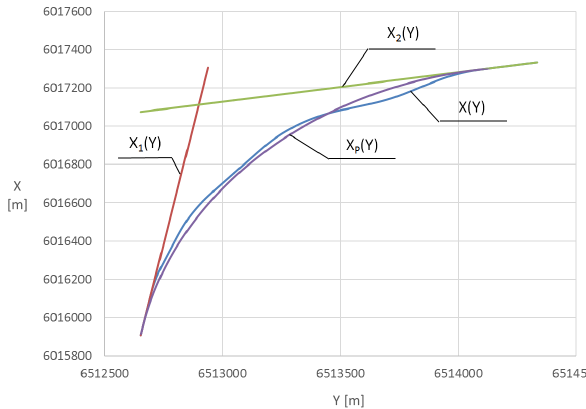
Figure 8: The existing and the designed geometric lay-out in the na- tional system 2000; X ( Y ) – the existing course of the route, X 1 ( Y ) and X 2 ( Y ) – determined main directions of the route, X P ( Y ) – the designed course of the